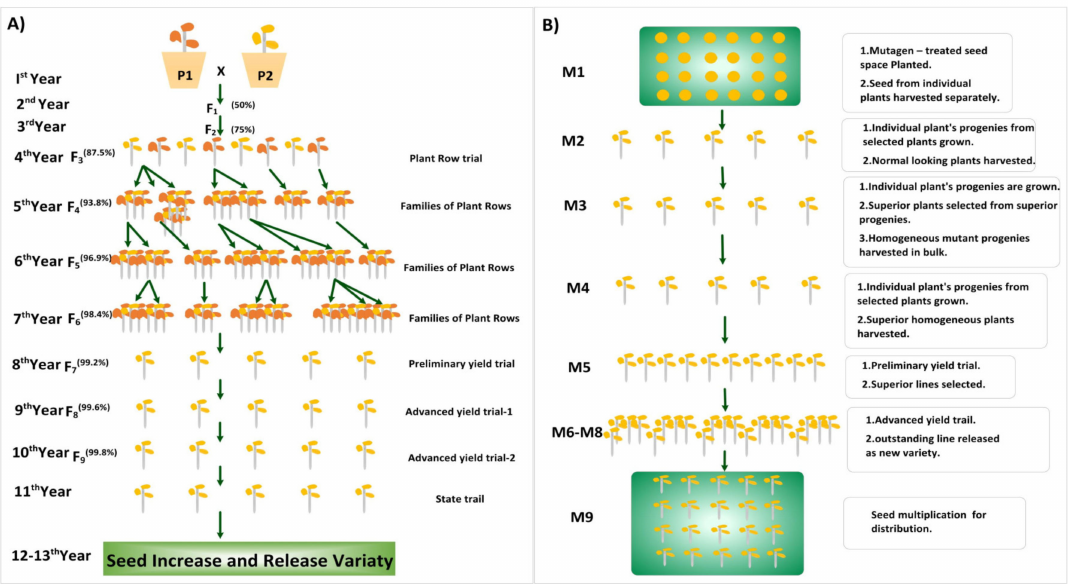
Figure 2. Improvement of agronomic traits using traditional breeding and chemical or physical mutagenic approaches. ( A ) Improving a trait (e.g., disease resistance) by the traditional breeding and for the introduction of the desired donor trait into the ‘chosen’ recipient line by selecting the progeny with the desired traits from the recipient line and crossing it with the donor line. ( B ) This process uses chemical or physical mutagens to generate mutants via random